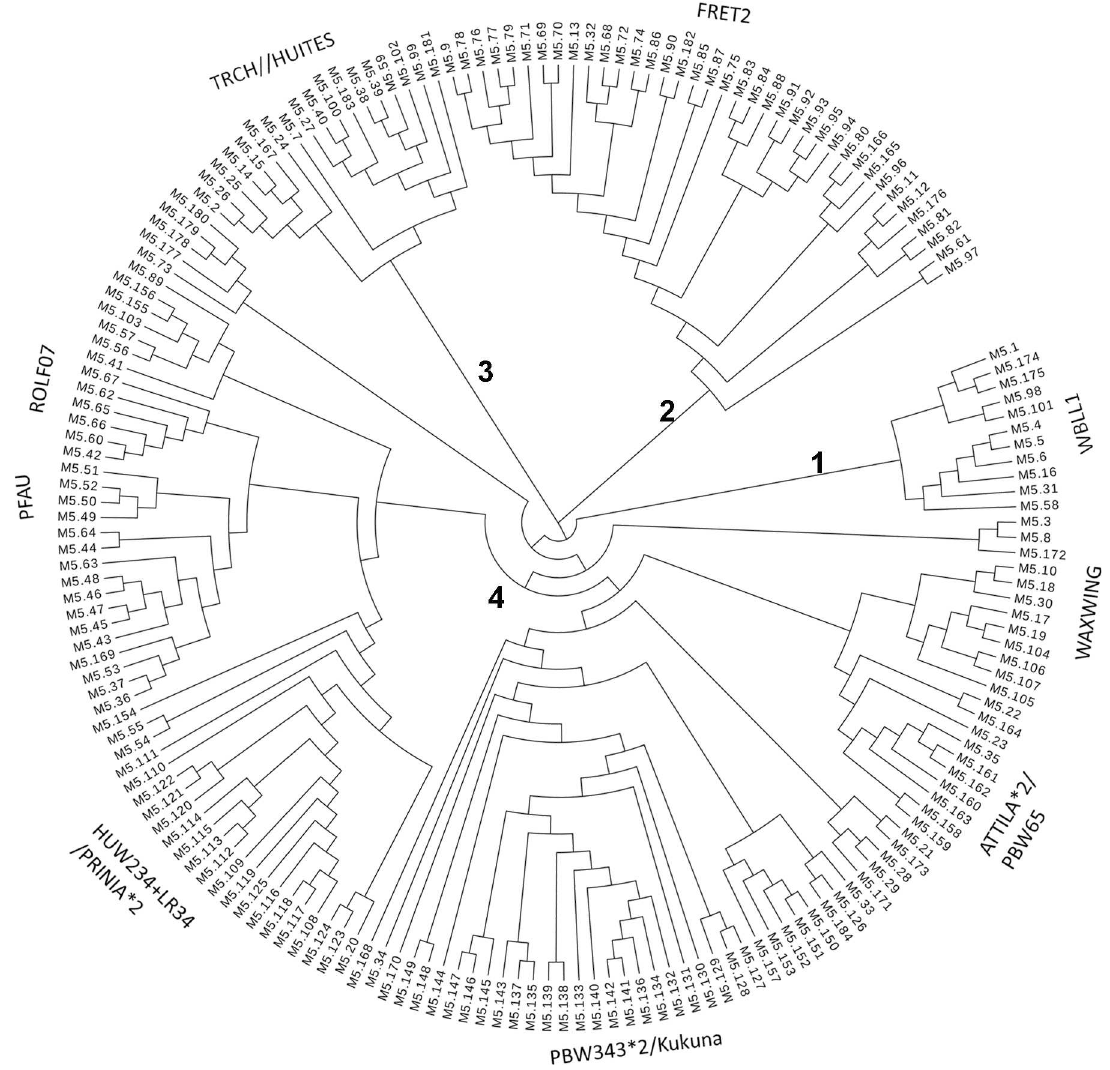
Fig 1. A dendrogram illustrating the clusters produced by hierarchical clustering of wheat lines in the 5 th SRRSN. Clusters with similar pedigreesand genetic backgrounds were namedby their common parent.